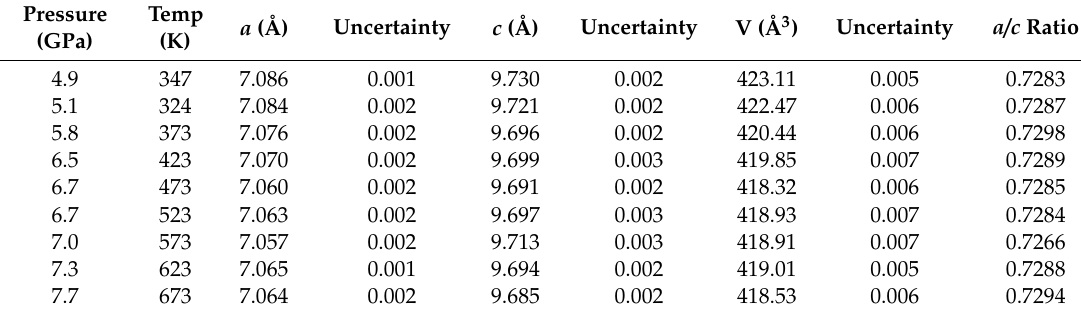
Table 5. Bastnäsite-(La) measured lattice parameters, unit cell volumes, and a / c crystallographic